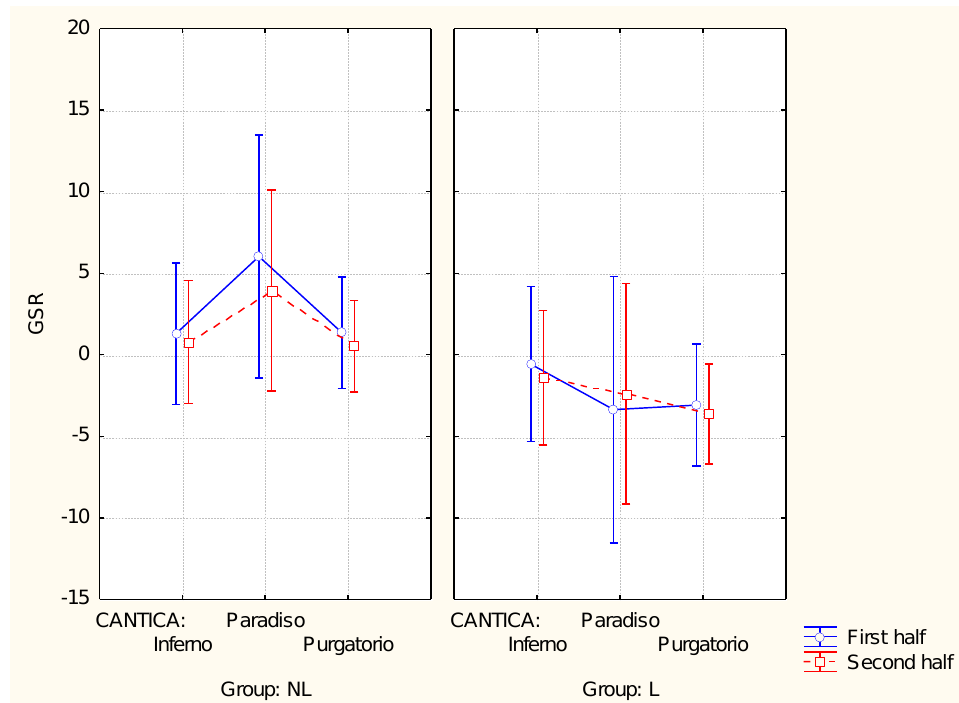
Figure 2. Graph representing the significant interaction between the factors: CANTICA (Inferno, Paradiso and Purgatorio), HALF (first and second half segments) and GROUP (L: Literature students; NL: Non-Literature students) resulting from the ANOVA analysis for the GSR index. Vertical bars denote 0.95 confidence interval.